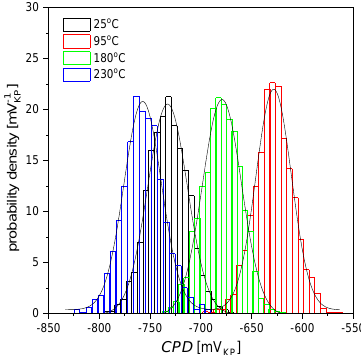
Figure 7. Contact potential difference ( CPD ) maps for the AISI 1010 steel electrodes immersed in sulfolane at 25 ( a ), 95 ( b ), 180 ( c ), and 230  C ( d ); V KP is the voltage measured versus Kelvin probe.